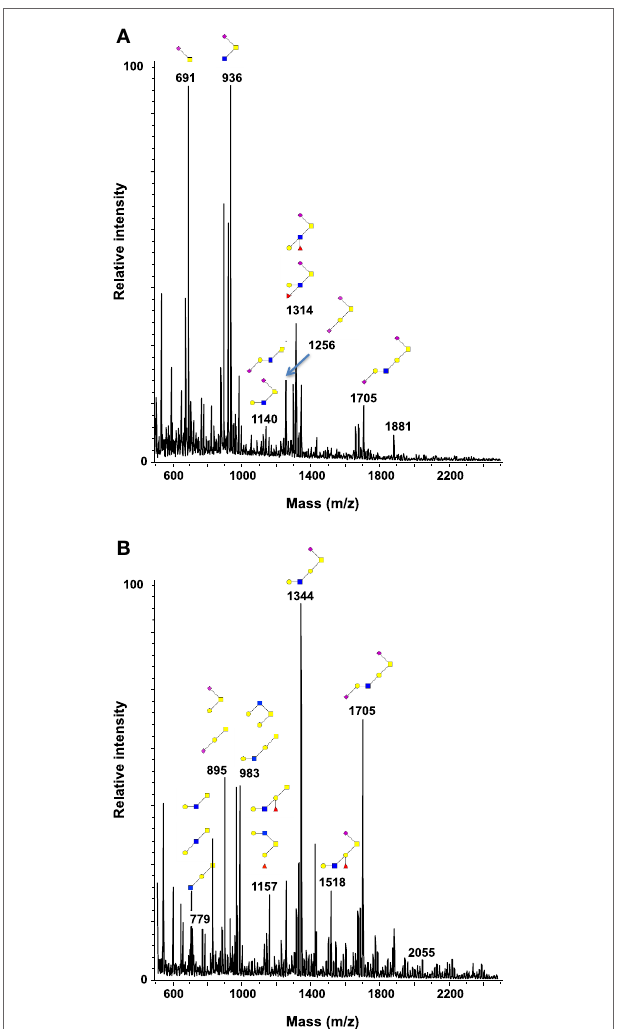
FigUre 4 | comparison of the glycosylation pattern of mucins purified from colorectal tumors with or without recurrence . MALDI-MS spectra, acquired in the positive ion mode [M + Na] + (or [M + 2Na-H] + for sulfated species), of human intestinal permethylated O-glycans from mucins purified from ( a) tumors with recurrence; (B) tumors without recurrence. Monosaccharide symbols according to the Consortium for Functional Glycomics (CFG) nomenclature. Key: fucose (red triangle), GlcNAc (blue square), sialic acid (purple diamond), galactose (yellow circle), GalNAcol (yellow square), and sulfate residue